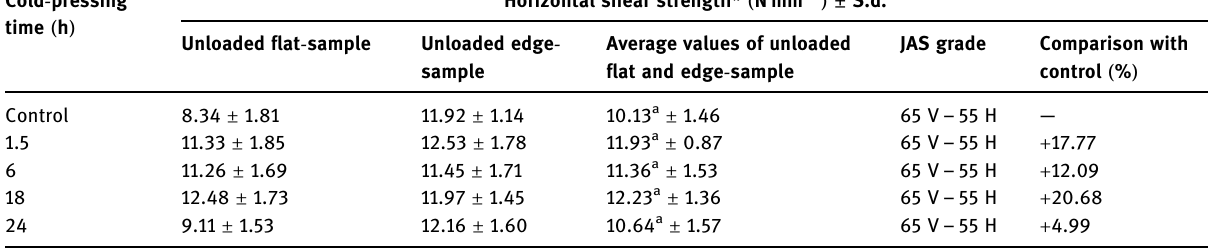
Horizontal shear strength* ( N mm − 2 ) ± S.d.